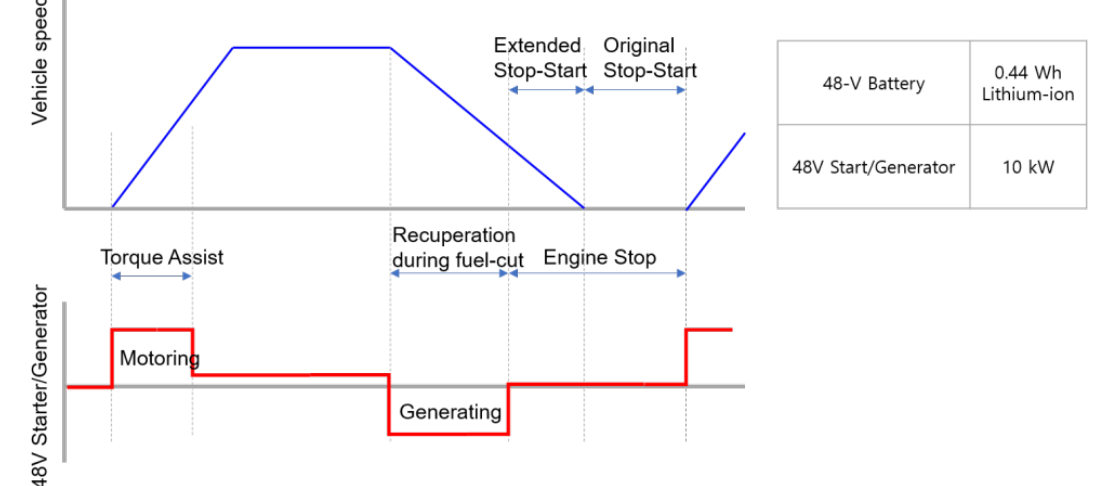
Figure 23. Strategy for capacity and control of 48-V starter / generator for improving fuel consumption.